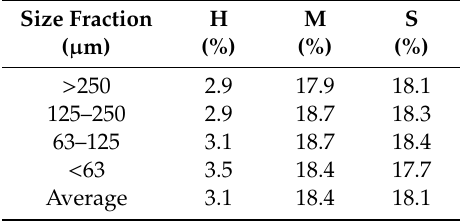
Table 5. Total Cu content of the di ff erent size fractions and average value of samples H, M, and S.